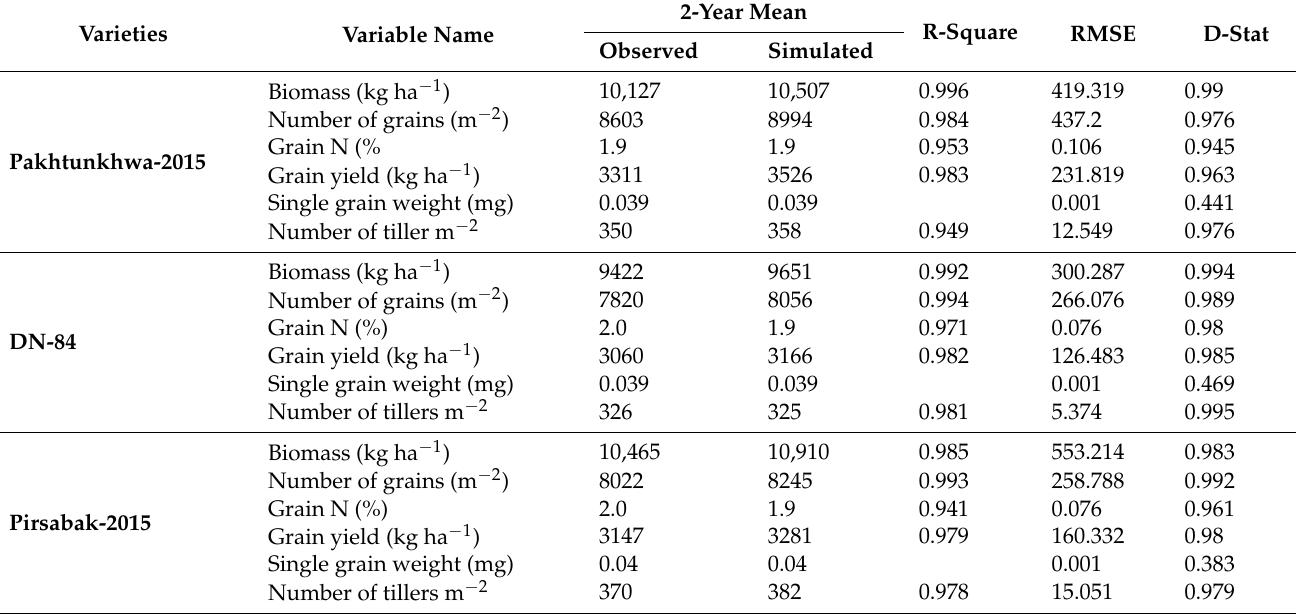
Table 3. Performance of the CERES-Wheat model version 4.7.5 for simulating yield traits, yield, and grain nitrogen content of wheat during 2016–17 and